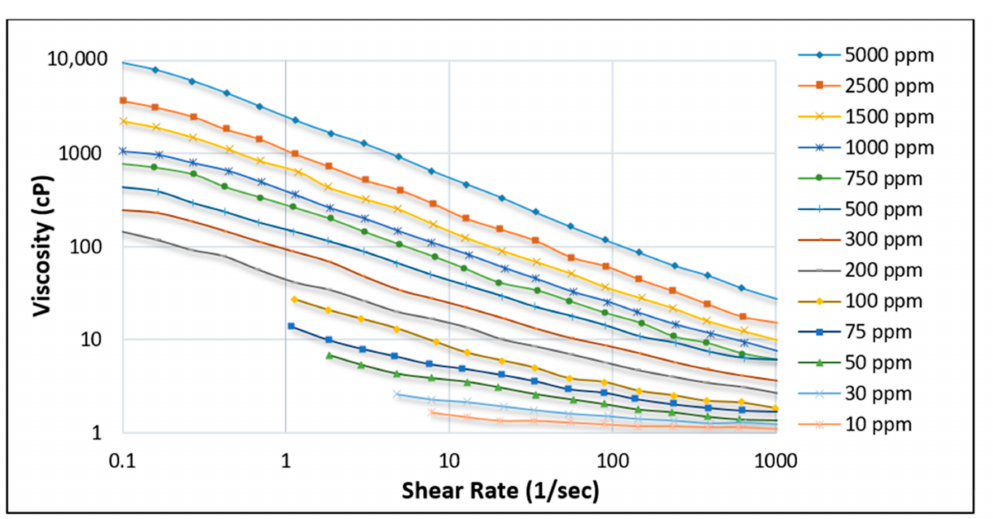
Figure 11. E ff ect of shear rate on the viscosity of HPAM solution at various concentrations